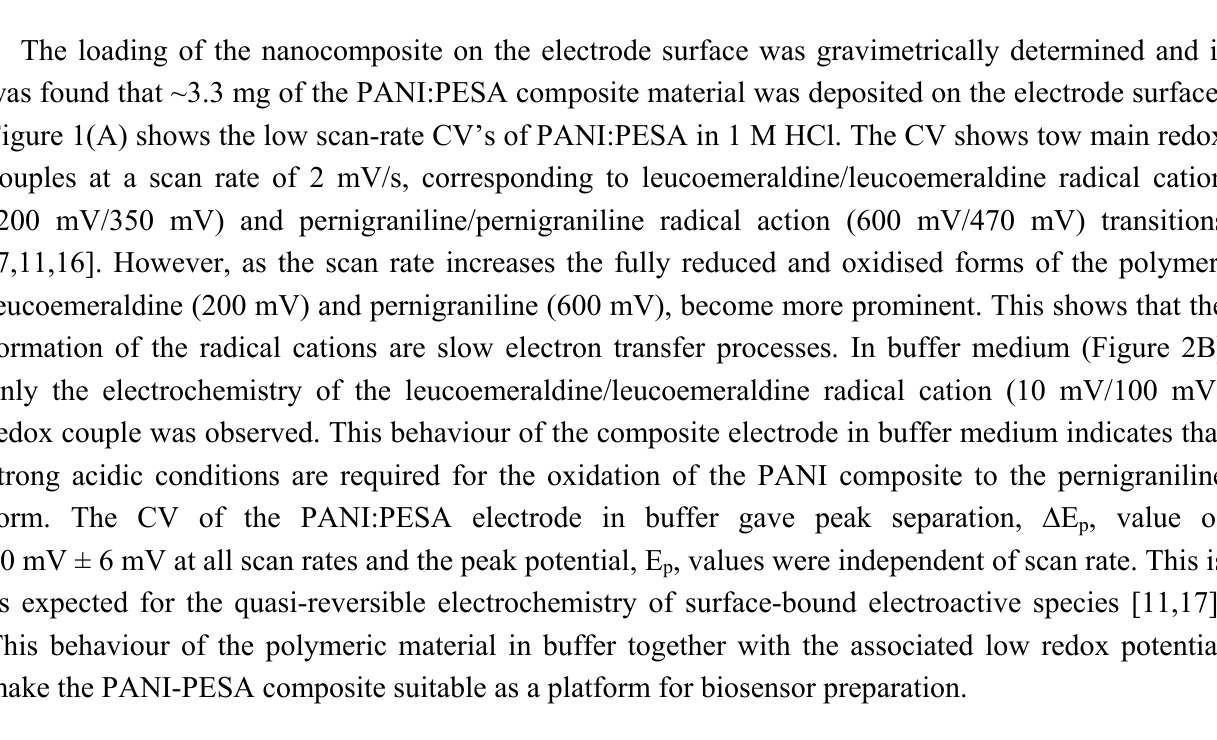
Figure 1. CV of PANI:PESA nanocomposite in (A) 1 M HCl and (B) in 0.1 M phosphate buffer (pH